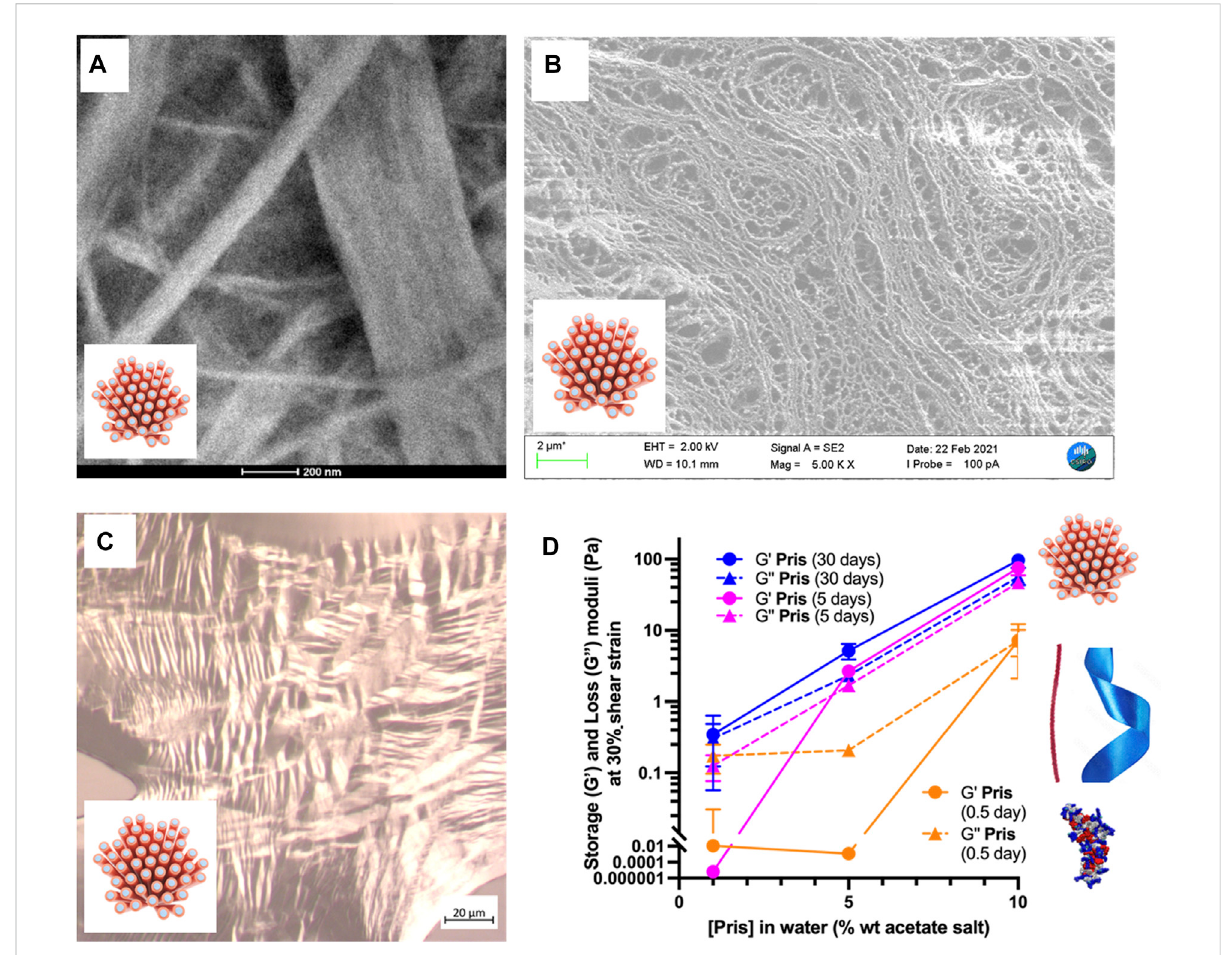
FIGURE 6 Priscilicidinnanostructured samples: mesophasicand viscoelastic properties. (A) 10% att = 5 days. Scale bar 200 nm; (B) 5% att = 5 days. Scale bar2 μ m; (C) 10% w/whydrogel(3 daysold),driedonslideshowingnematicopticaltextures.Scalebar20 μ m; (D) G ’ andG ” valuesat30%strainover Priscilicidin concentration and time